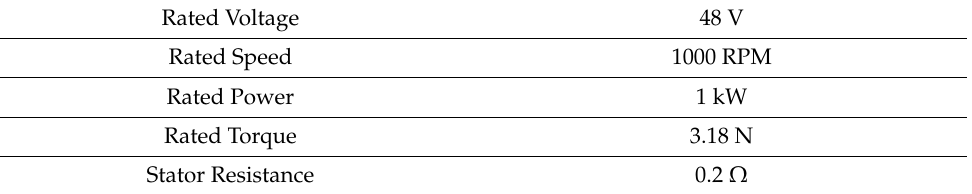
Table 2. Specific parameter of ac servo motor.